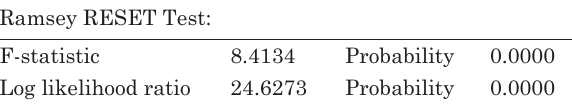
Table 4. Structural change test